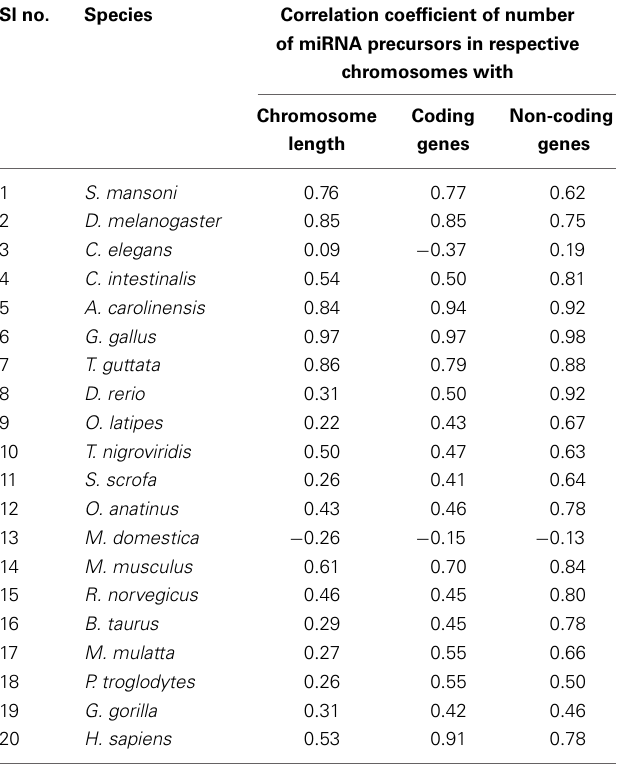
Table 2 | Correlation coefficient of number of miRNA precursors vs. chromosome length, number of coding and non-coding genes in the respective chromosome.